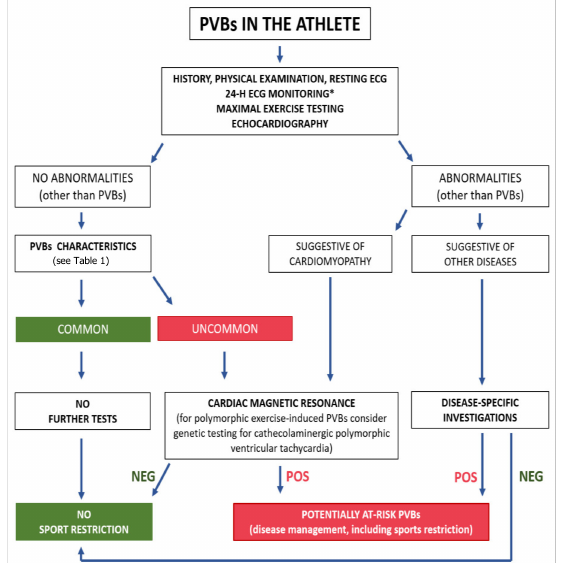
Figure 7. Proposed algorithm for evaluation of athletes with premature ventricular beats. * Twenty- four-hour ECG monitoring should ideally have a 12-lead configuration and include a training session. NEG, negative; POS, positive; PVBs, premature ventricular beats. Reproduced with permission from